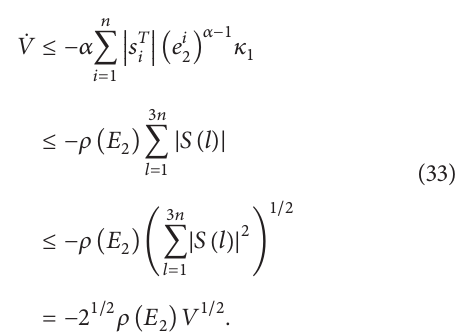
For 𝑒 𝑘 2 ̸= 0, 𝑘 = 1, 2, . . . , 𝑛 , 𝜌(𝐸 2 ) > 0 , then we have